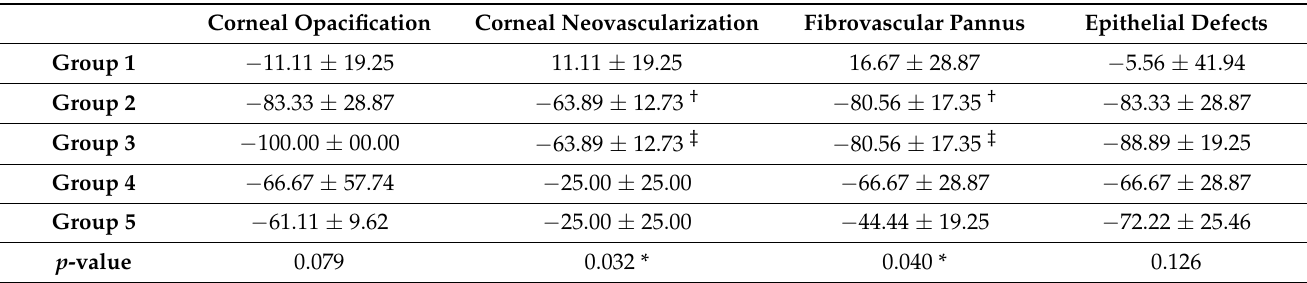
Table 3. Percentage of change before and after treatment for each clinical variable measured. Data are shown as mean ± standard deviation